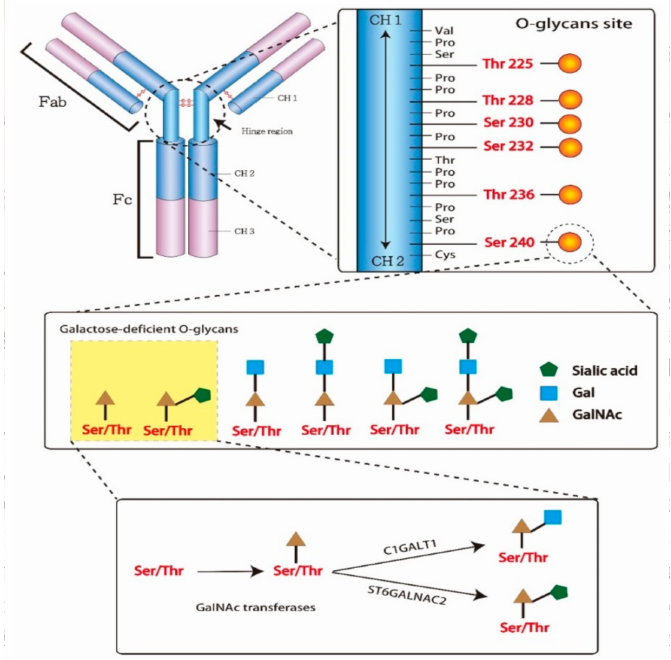
Figure 2. Structure of immunoglobulin A1 (IgA1) hinge region with O-glycans. In the hinge region, IgA1 potentially has three to six O-glycans. The O-glycan attached to IgA1 via the link with serine/threonine residues and oxygen atoms. The structure of O-glycans consisted of N -acetylgalactosamine (GalNAc), galactose and/or sialic acid. The attachment of GalNAc to serine/threonine residues by GalNAc transferases is first step of glycosylation. Second step, the GalNAc can be added galactose by glycoprotein N -acetylgalactosamine 3- β -galactosyltransferase (C1GALT1) or sialic acid by α - N -acetylgalactosaminide α 2,6-sialyltransferase 2